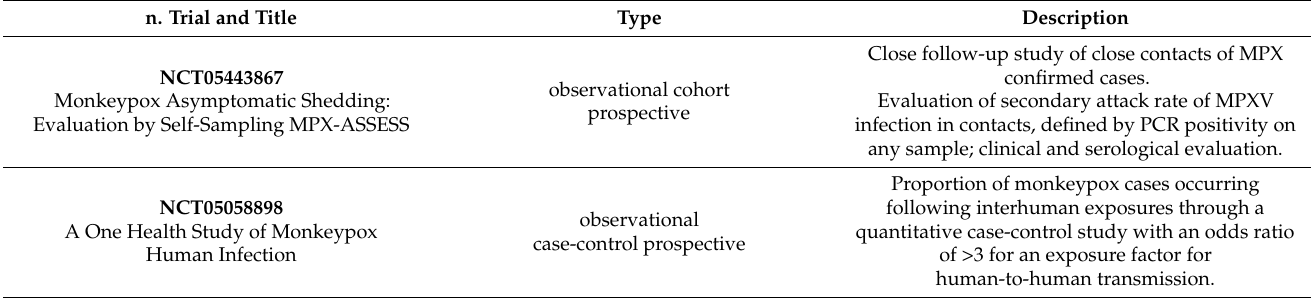
Table 1. Currently ongoing clinical trials for MPX